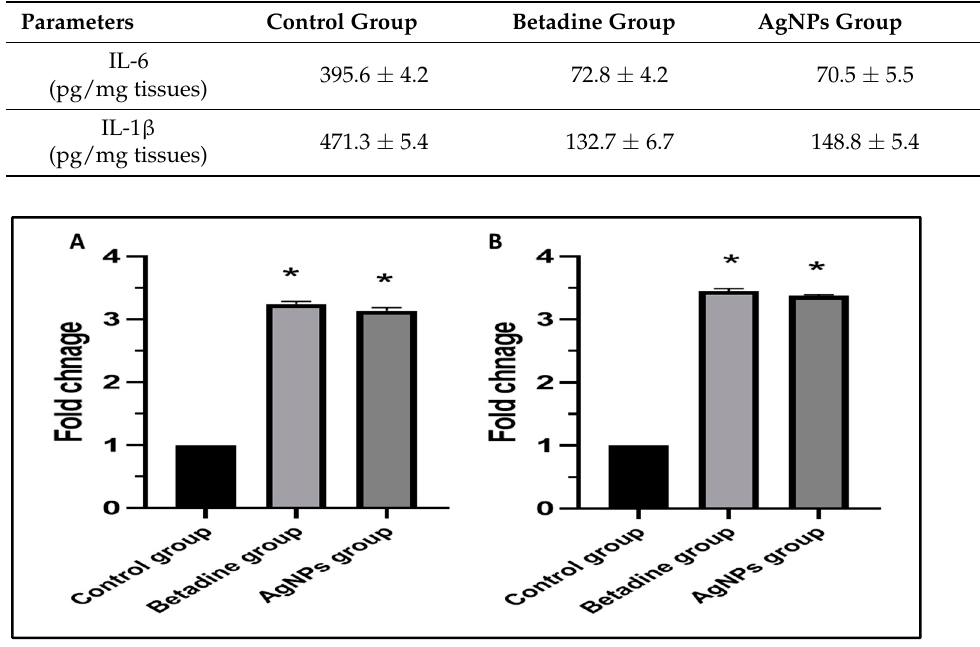
Figure 16. Bar charts represent the fold change in the gene expression of ( A ) fibronectin and ( B ) PDGF genes. The symbol (*) denotes a significant increase ( p < 0.05) relative to the control